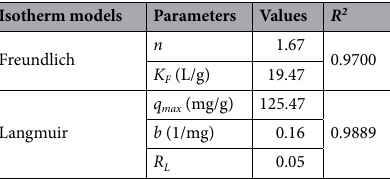
Table 6. Parameters of Freundlich and Langmuir isotherms for adsorption of Cd(II) onto HAp/bentonite composite.